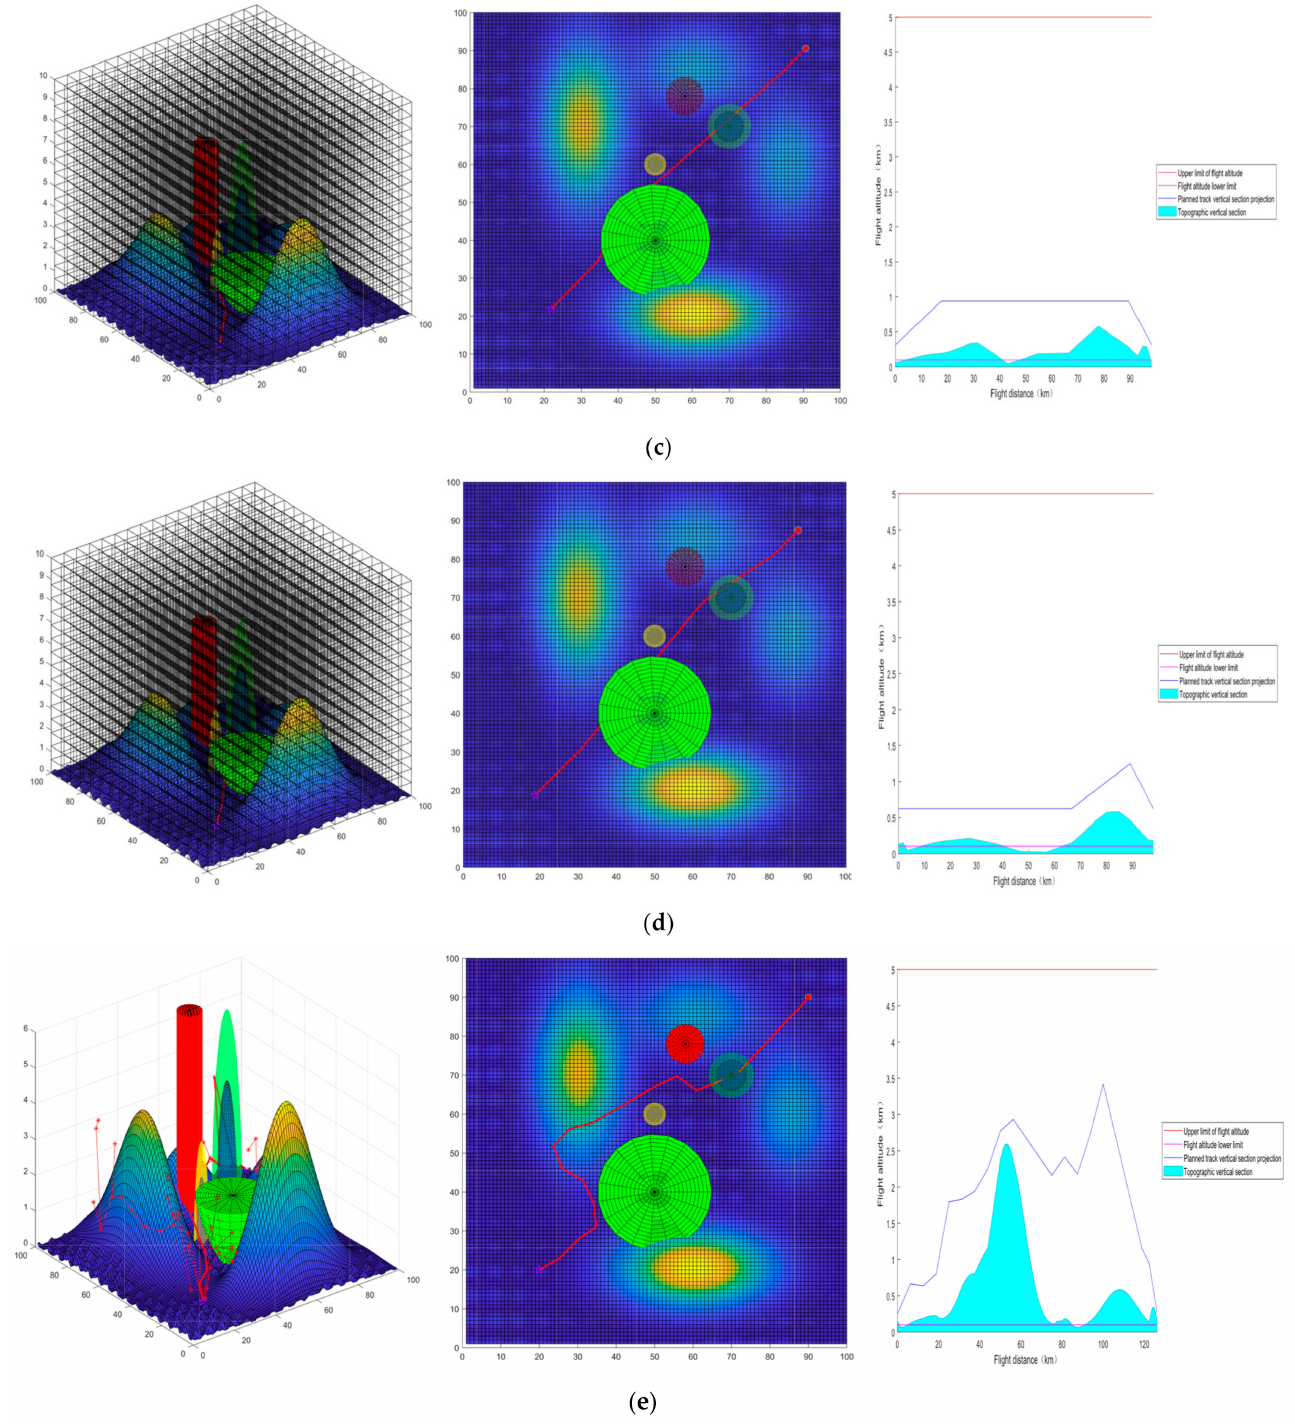
Figure A4. When N = 5, the comparison experiment of the route planning algorithm’s planning result, top view, and altitude change curve. ( a ) Grid-based route planning with the A* algorithm, ( b ) A* algorithm route grid point-based planning, ( c ) Grid-based route planning with Lazy Theta* algorithm, ( d ) Grid point-based Lazy Theta* route planning, and ( e ) RRT* route planning using